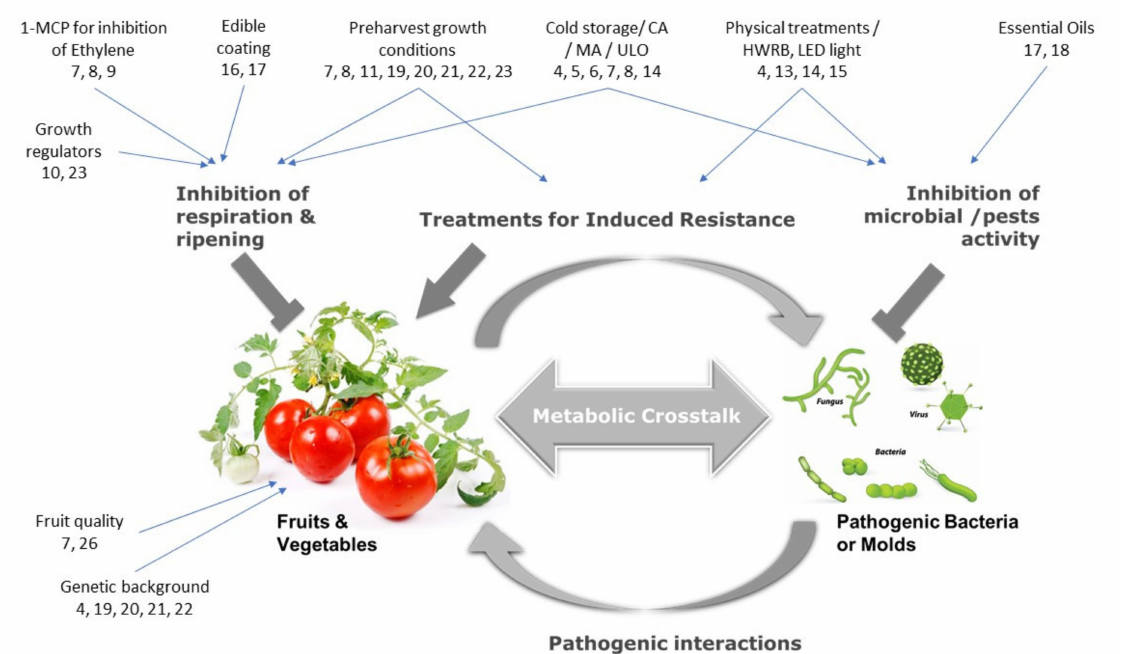
Figure 1. Current and emerging approaches to preventing postharvest deterioration of fresh produce (for more details, see text). Specified numbers refer to the relevant references cited along the manuscript. Conflicts of Interest: The authors declare no conflict of